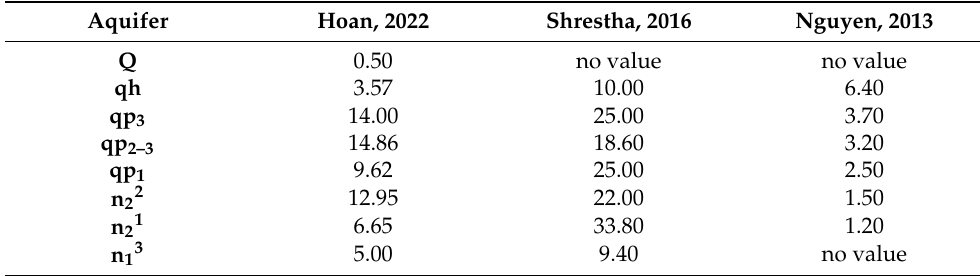
Table 3. Comparison average of hydraulic conductivity. Aquifer Hoan,